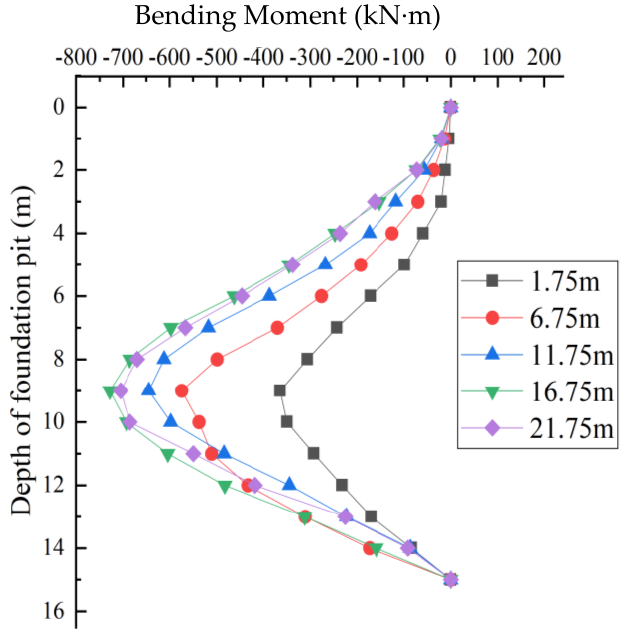
Figure 14. Pile bending moments.